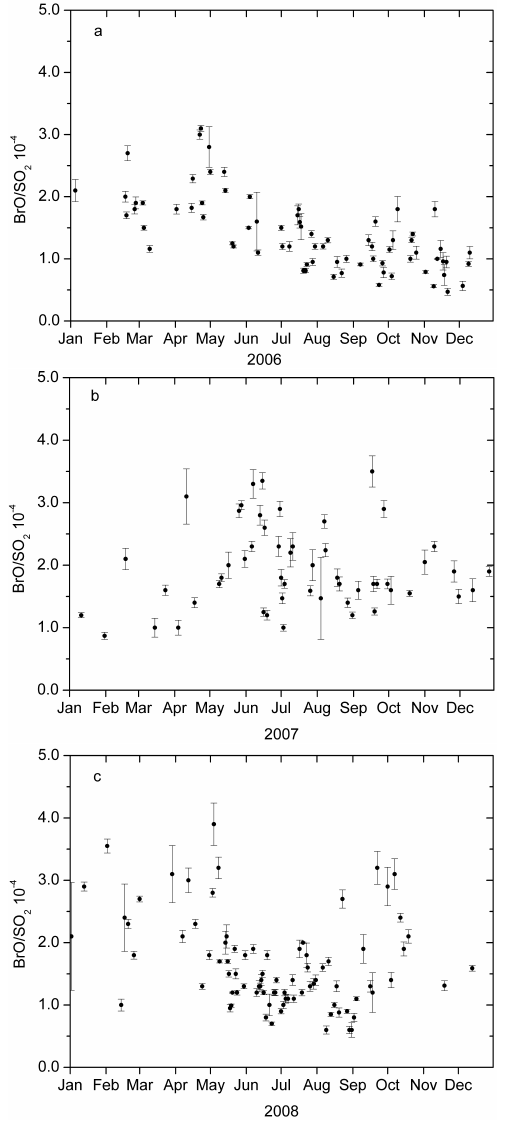
Fig. 4. BrO/SO 2 ratios are shown as a function of time split into three years of observations: (a) 2006–2007 highest BrO/SO 2 val- ues in spring, (b) 2007–2008 highest BrO/SO 2 peaks during the summer, generally higher variability than under (a) , and (c) 2008– 2009 highest BrO/SO 2 values in spring and autumn. No periodicity of seasons can be identified. Data points and error bars calculated as in Fig.